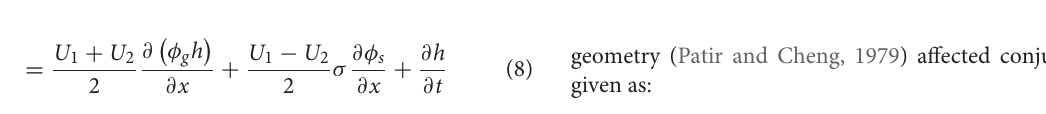
FIGURE 2 | (A) Out-of-round second order bore, of 15 µ m radial difference. (B) Out-of-round fourth order bore, of 5 µ m radial difference. (C) Out-of-round eighth order bore, of 5 µ m radial